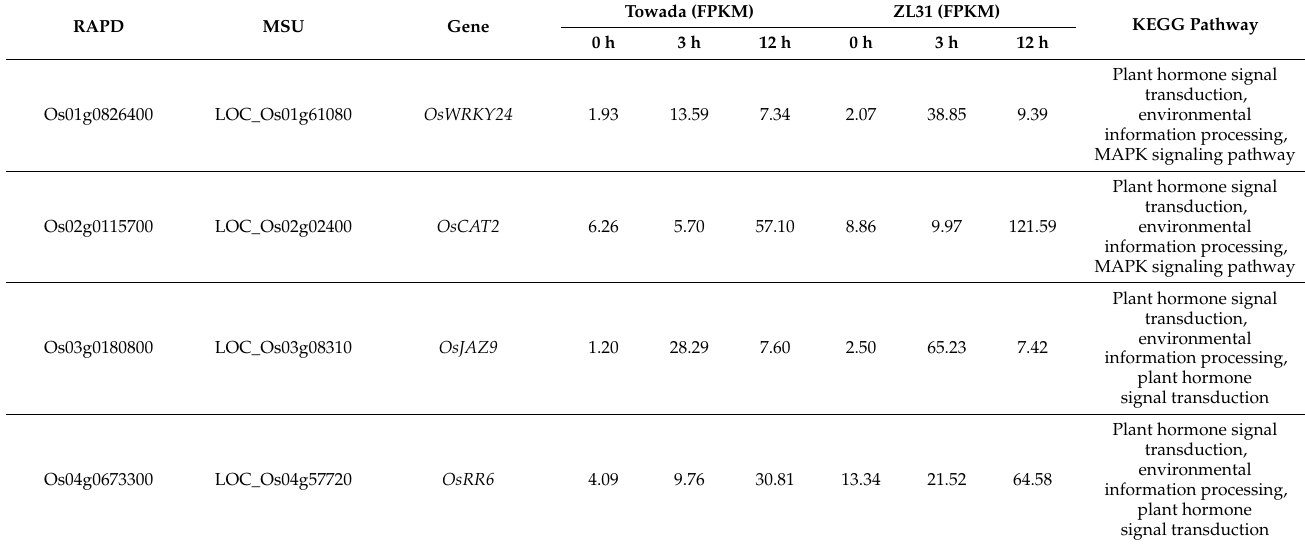
Table 1. List of core genes, the expression spectrum, and the KEGG pathway in Towada and ZL31.